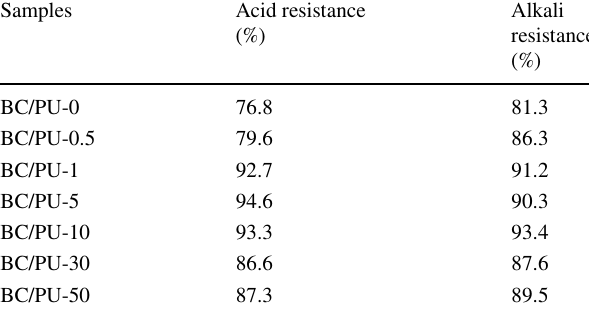
Table 2 The durability of BC/PU foam composites